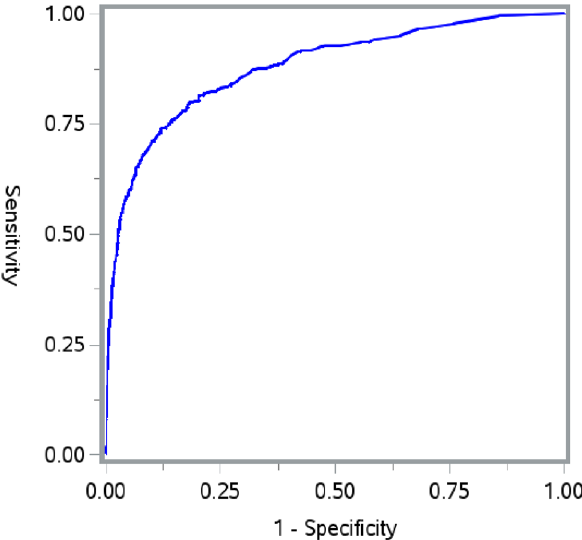
Figure 1. Receiver operating characteristics (ROC) curves for the model in differentiating stage T1 colorectal cancer with distant metastases from those without distant metastases. The area under the ROC curve was